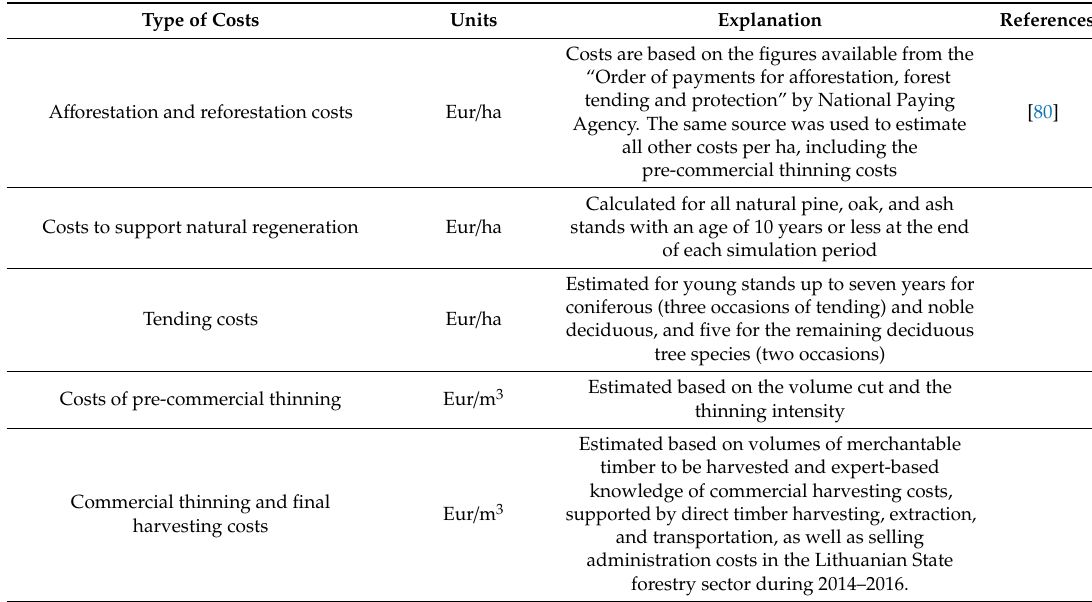
Table A2. Types of forestry-related expenses used to estimate the costs of silvicultural